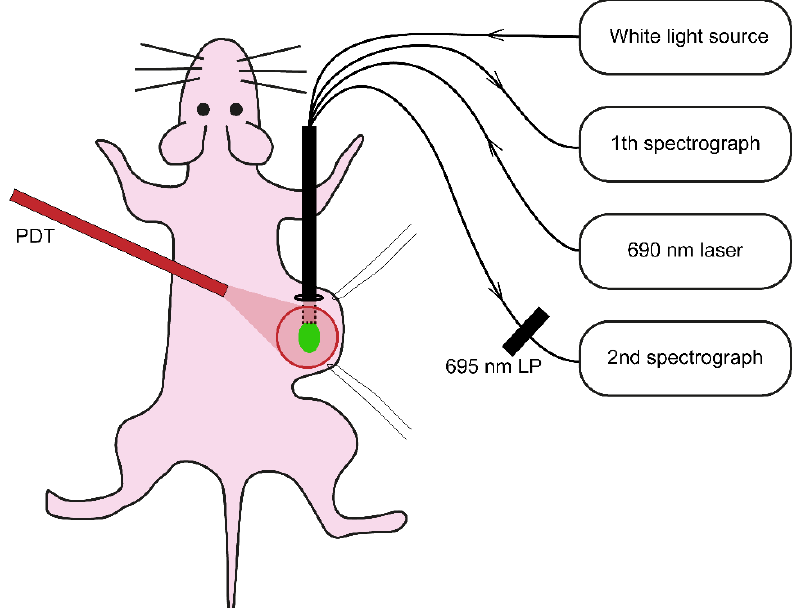
Figure 8. Schematic drawing of the illumination and single fiber spectroscopy set-up.